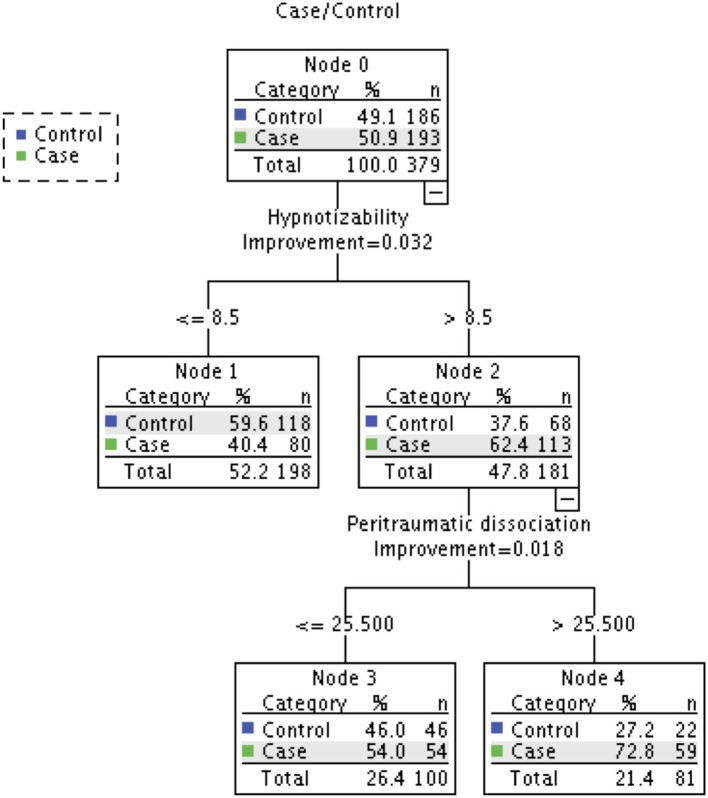
Classification tree produced by CART analysis. Dependent variable: Case/Control; Independent variables: Physical Neglect, Emotional Neglect, Emotional Abuse, Sexual Abuse, Physical Abuse, Fantasy Proneness, Cognitive Failures, Emotional Contagion, Depression, Peritraumatic Dissociation, Post-traumatic Stress, Hypnotizability, Quality of Life, Dissociative experience. Node 0 contains frequency counts and percentages of all observations in the model, while all other nodes display the number and percentage of participants in that particular subgroup and the percentage of accurate classification of group membership (i.e., case or control) by that particular subgroup of a variable.